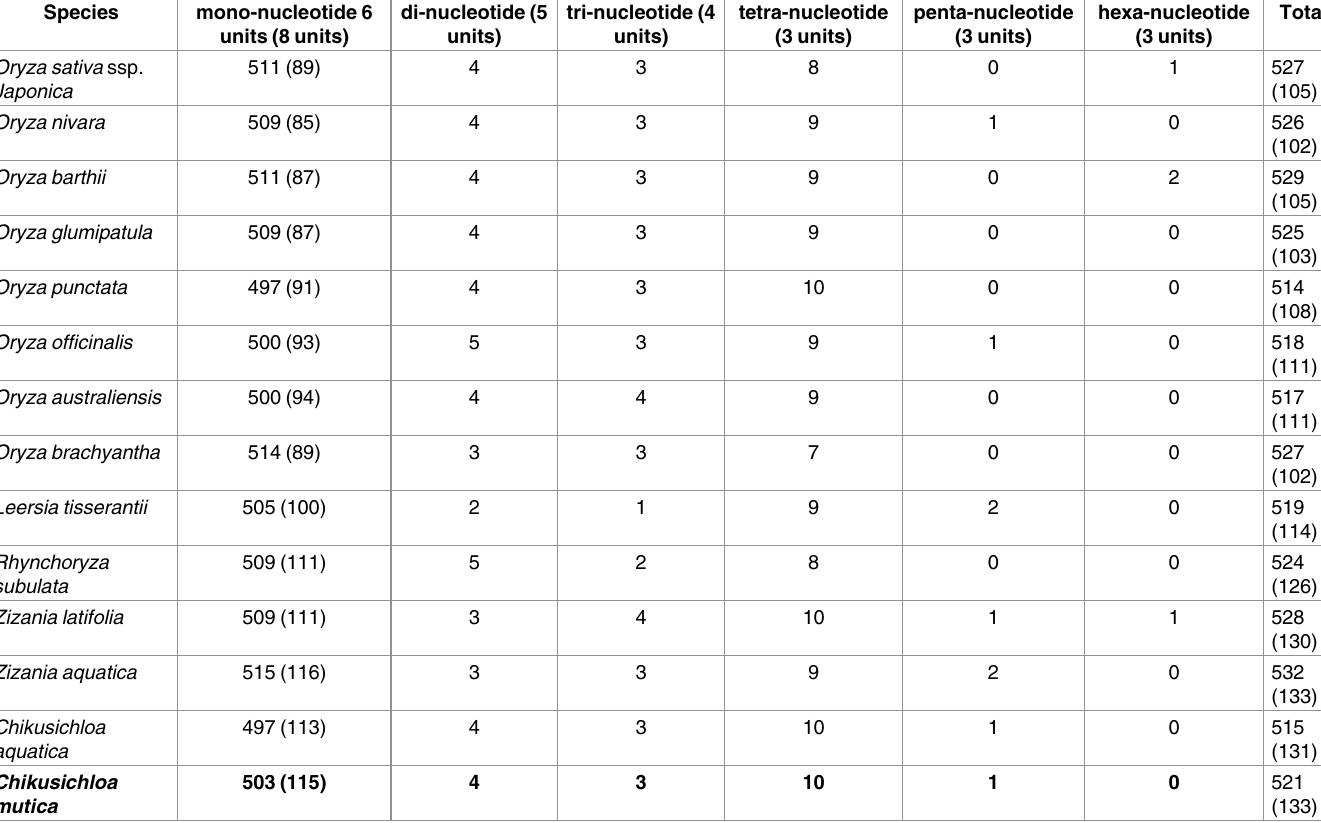
Table 3. Comparison of the number of SSRs of 14 chloroplast genomes from rice tribe. Species mono-nucleotide 6 di-nucleotide (5 tri-nucleotide (4 tetra-nucleotide penta-nucleotide hexa-nucleotide units (8 units) units) units) (3 units) (3 units) (3 units)